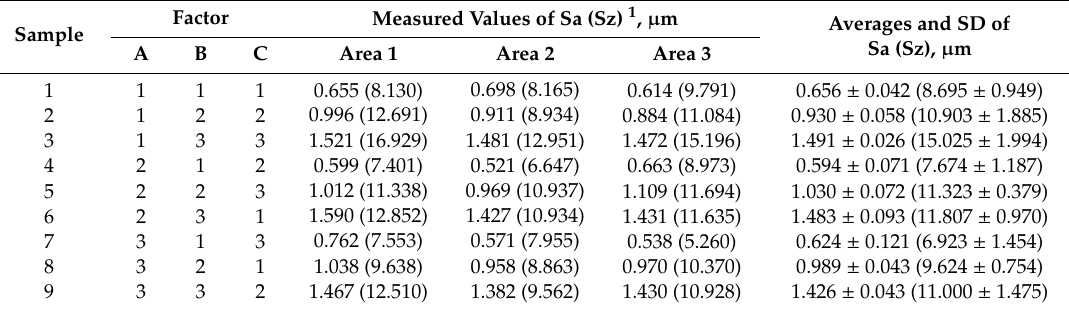
Table 2. The orthogonal experiment design and measurement results.